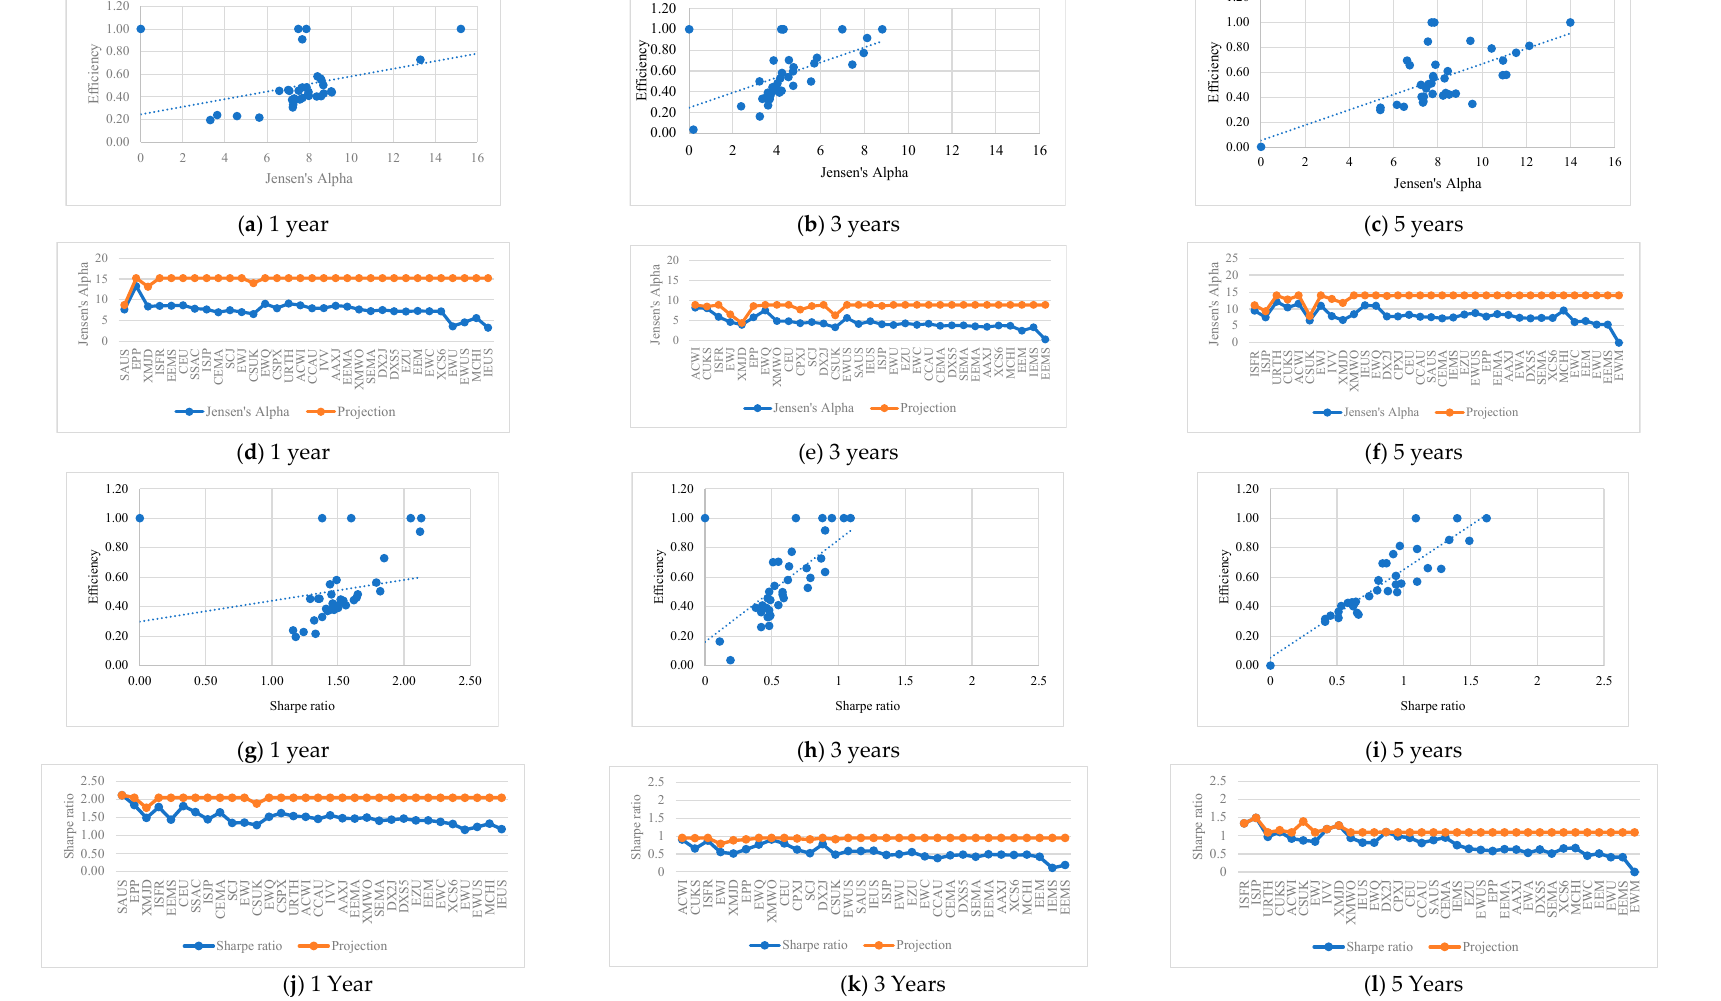
Figure 2. Efficiency scores vs. outputs and projections (ETFs are ordered in decreasing order of efficiency) for the different time